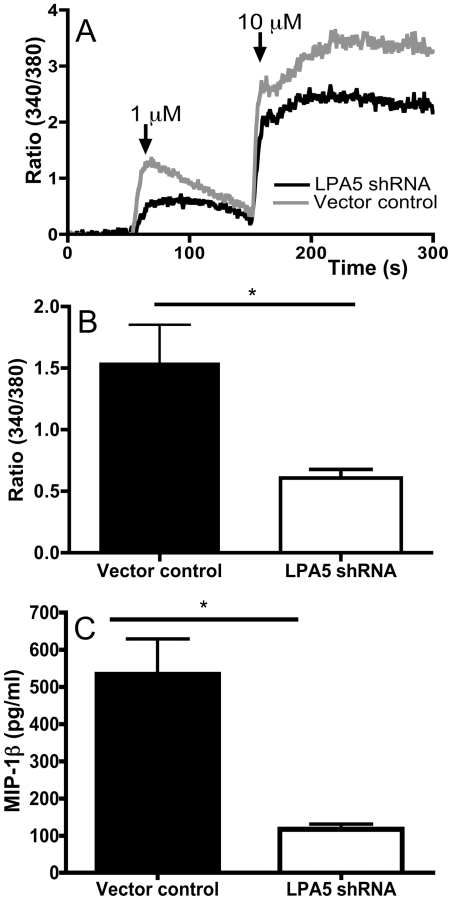
Influence of LPA5 silencing on functional responses in LAD2 cells.(A) Calcium flux in response to the indicated concentrations of LPA in control (grey tracing) or shRNA treated cells (black tracing). (B) Maximum calcium flux in response to 1 µM LPA represented in bar graph form (N = 3 Mean ± SD, *P<0.05). (C) MIP-1β release six hours after exposure to 1 µM LPA from cells transduced with control vector or LPA5 shRNA (N = 3 Mean ± SD, *P<0.05). Determinations performed in three independent experiments.